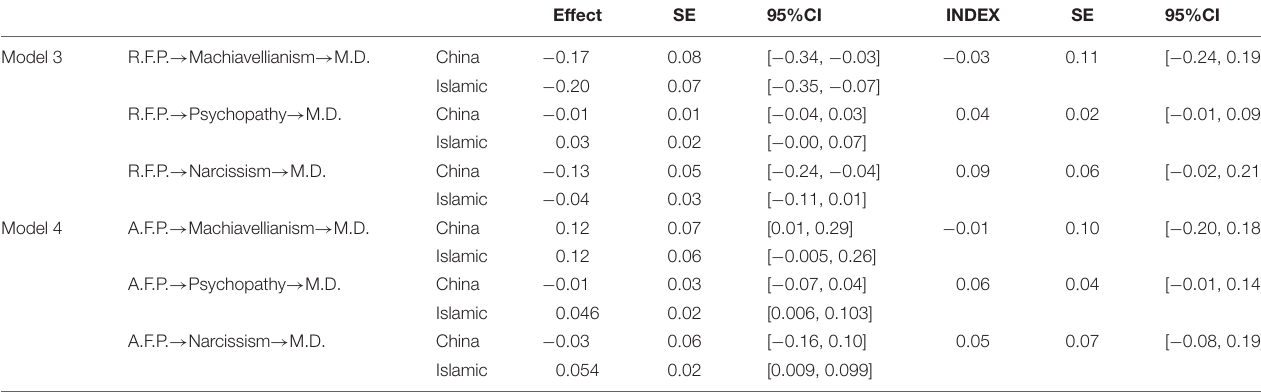
TABLE 4 | Culture differences in the mediation